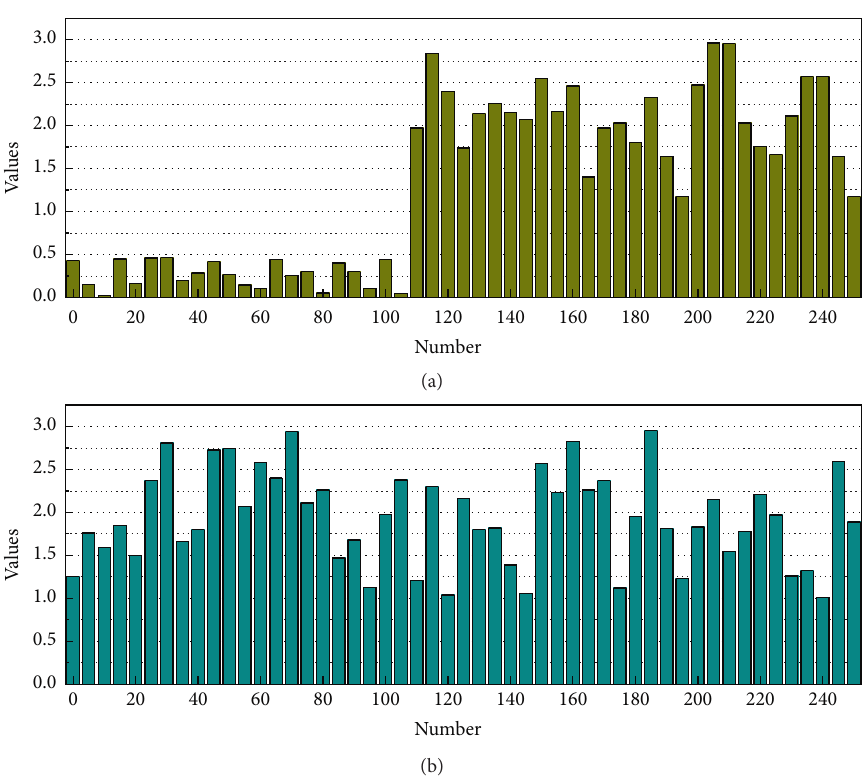
Figure 4: Histogram comparison before and after